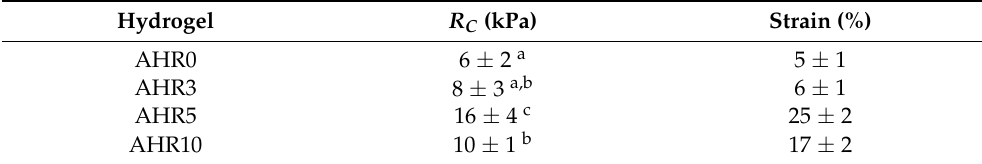
Table 2. Maximum compression resistance ( R C ) and strain percent of hydrogels.